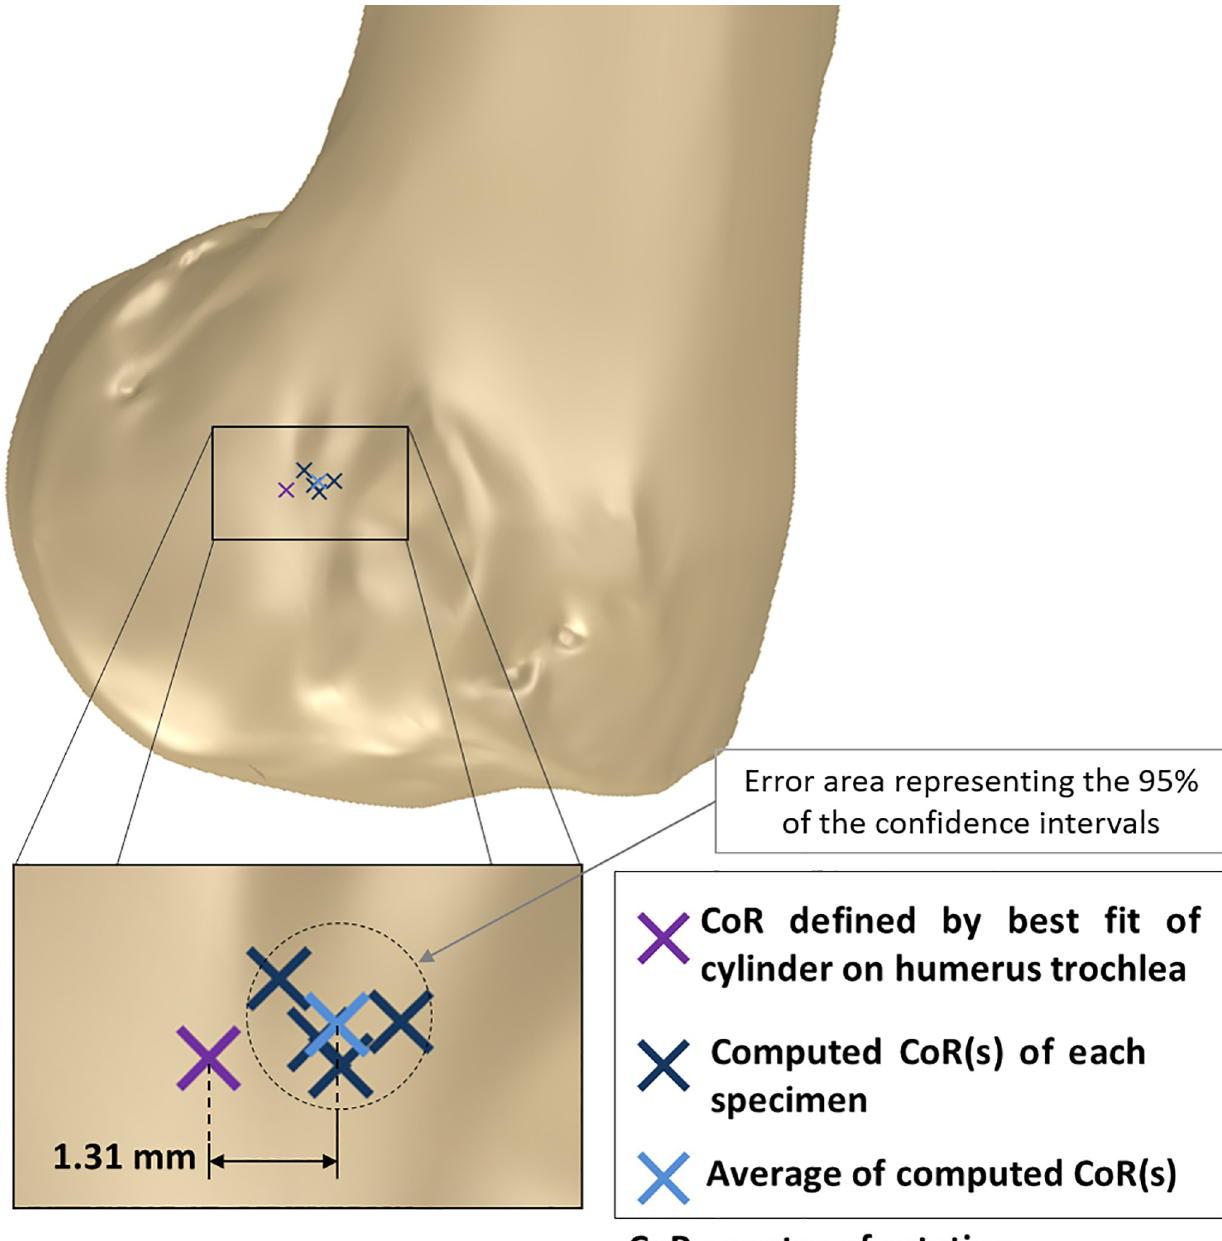
Fig 8. Mean rotation axis location on distal humerus epiphysis sagittal